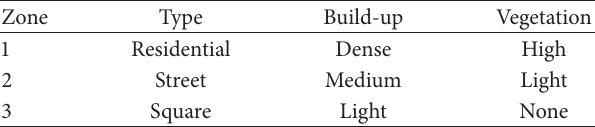
Figure 2: Regional and local position of Birobidzhan. Table 1: Selected locations (zones) and their respective